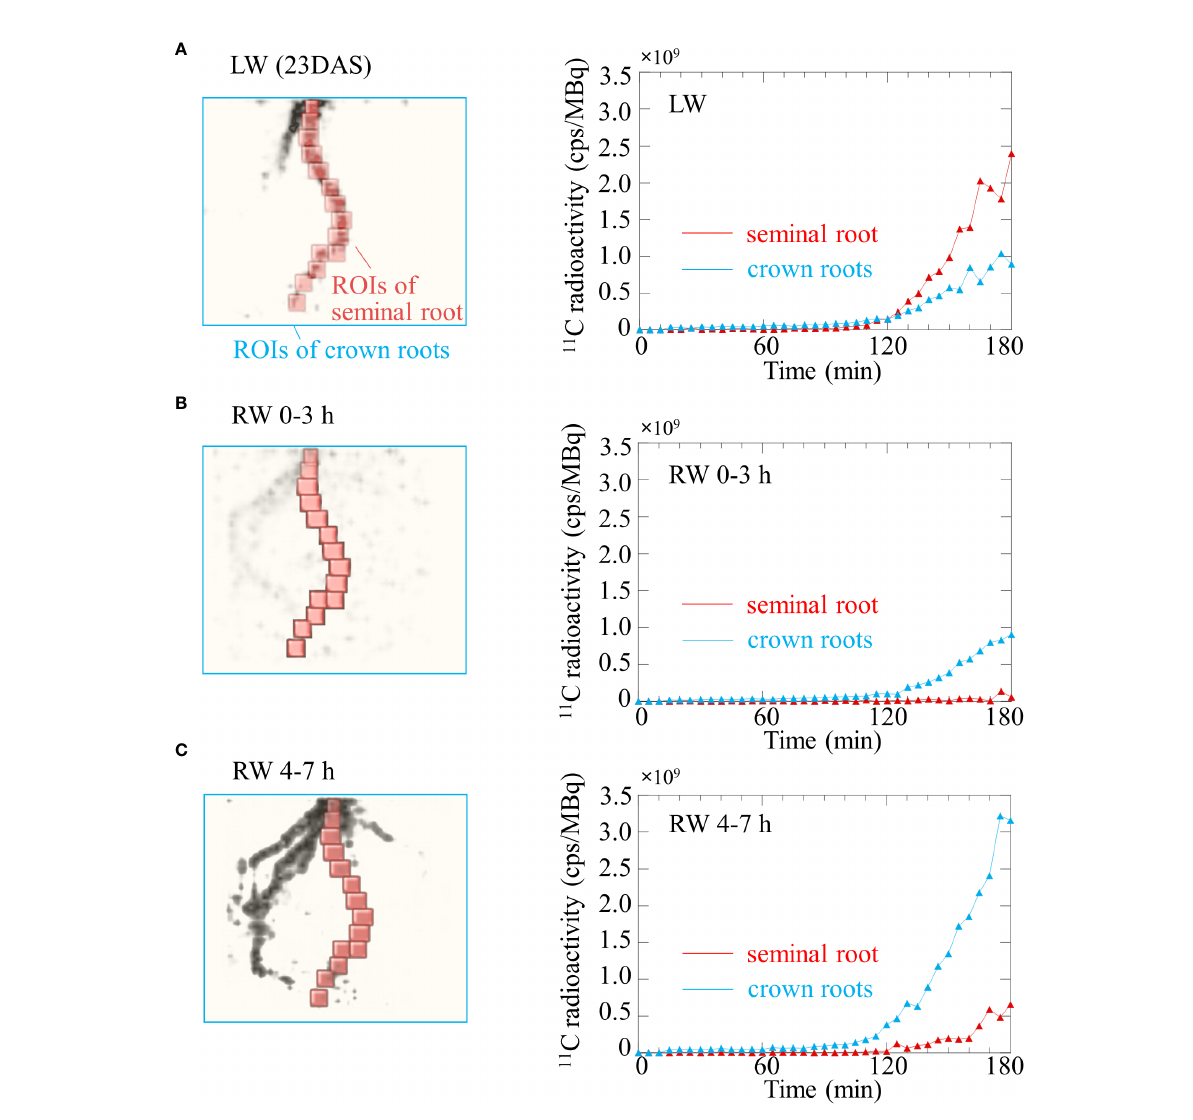
FIGURE 6 Time course of 11 C radioactivity in the seminal root (red line) and crown roots (blue line) of rice plant using OpenPET experiments shown in Figure 4 under (A) low water content (LW), (B) recover water content 0-3 h (RW 0-3 h), and (C) recover water content 4-7 h (RW 4-7 h). Regions of interest (ROIs) of the primary root and crown roots placed on OpenPET images are also shown. ROIs of crown roots does not include the seminal